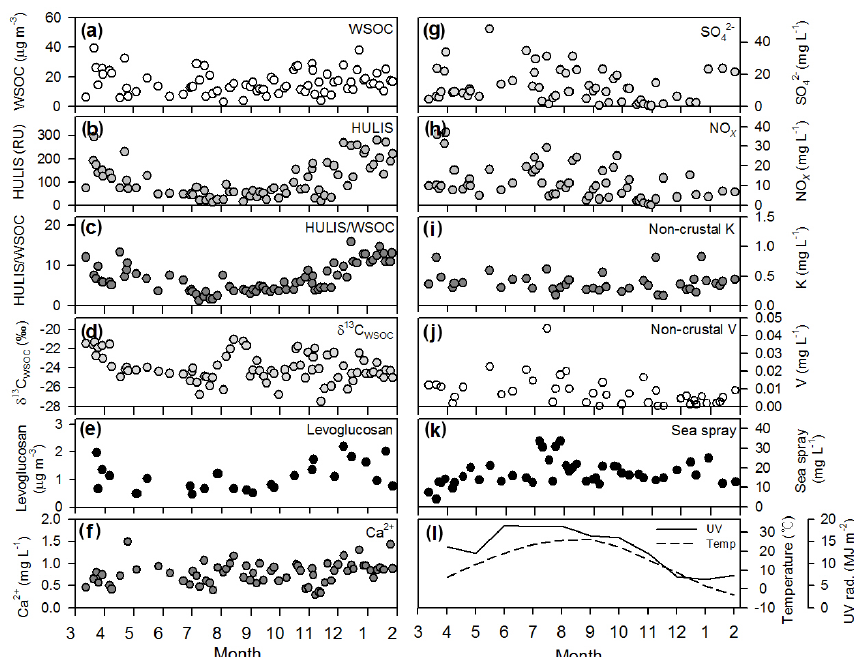
Figure 2. Temporal variations in (a) WSOC concentration, (b) fluorescence intensity of HULIS, (c) ratio of HULIS to WSOC, (d) δ 13 C WSOC values, (e) levoglucosan, (f) Ca 2 + , (g) SO 2 − , (h) NO x , (i) non-crustal K, (j) non-crustal V, (K) sea-spray concentrations, (l) UV radiation 4 rate, and temperature from March 2015 to January 2016 in Seoul, South